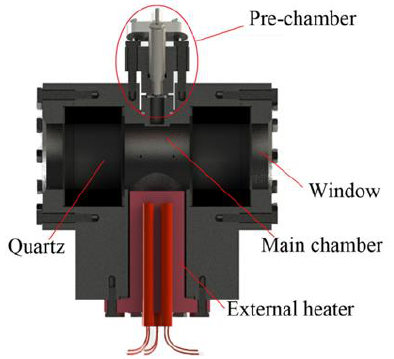
Figure 3. Structure of the constant volume chamber.